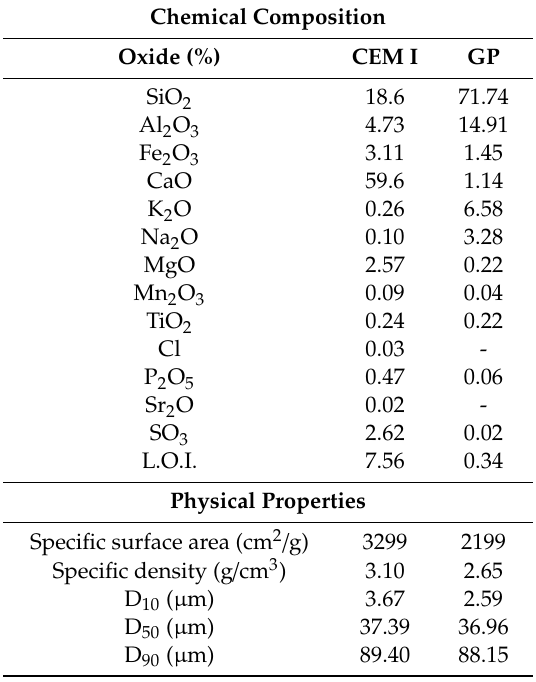
Table 2. Chemical compositions and physical properties of CEM I and granite